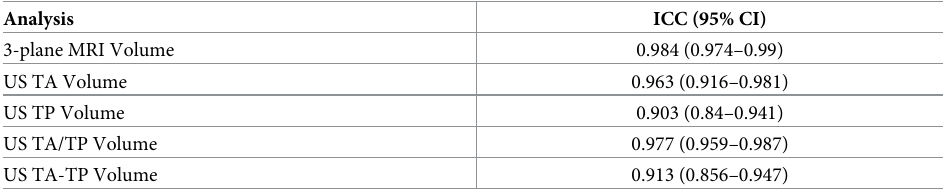
Table 4. Intraclass correlation coefficient (ICC) inter-observer agreement for MRI- and US- derived prostate